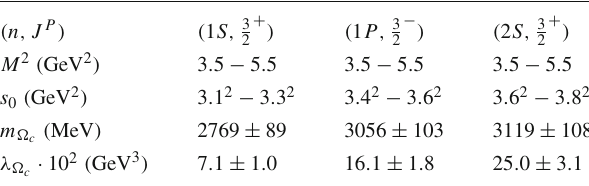
Table 2 The predictions for the masses and residues of the spin 3 / 2 (cid:2)